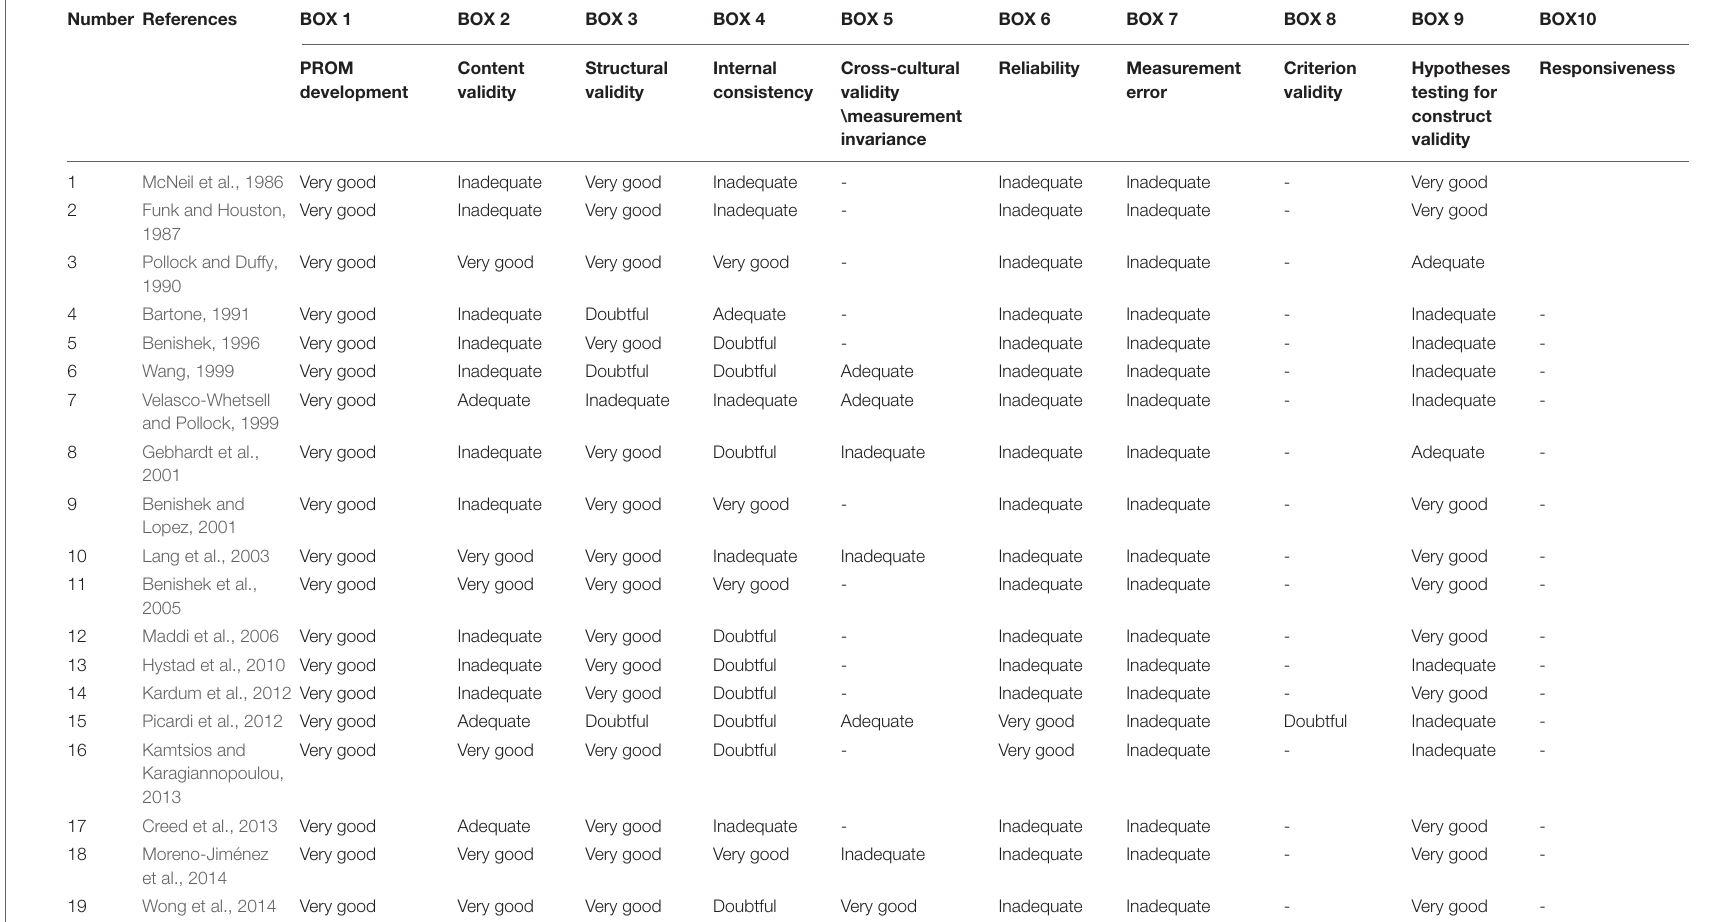
TABLE 2 | The COSMIN risk of bias